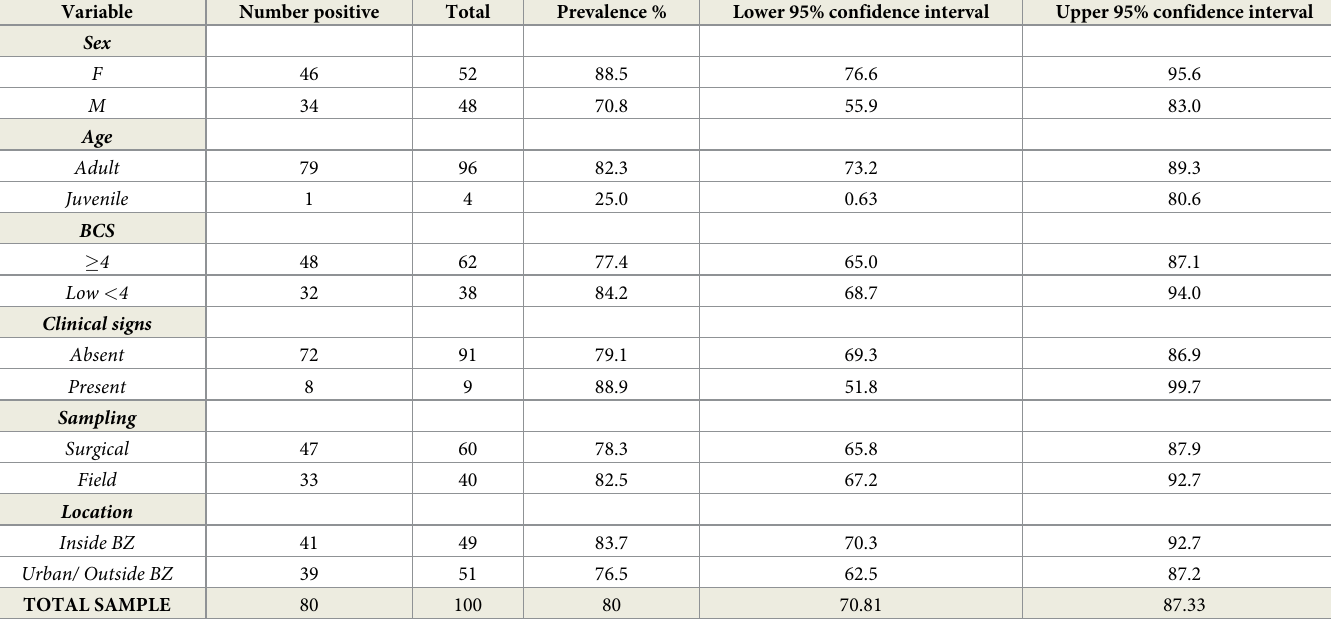
Table 1. Ancillary data collected from the free-roaming domestic dog population surrounding Chitwan National Park and seroprevalence to CDV associated with each of the recorded data variables.